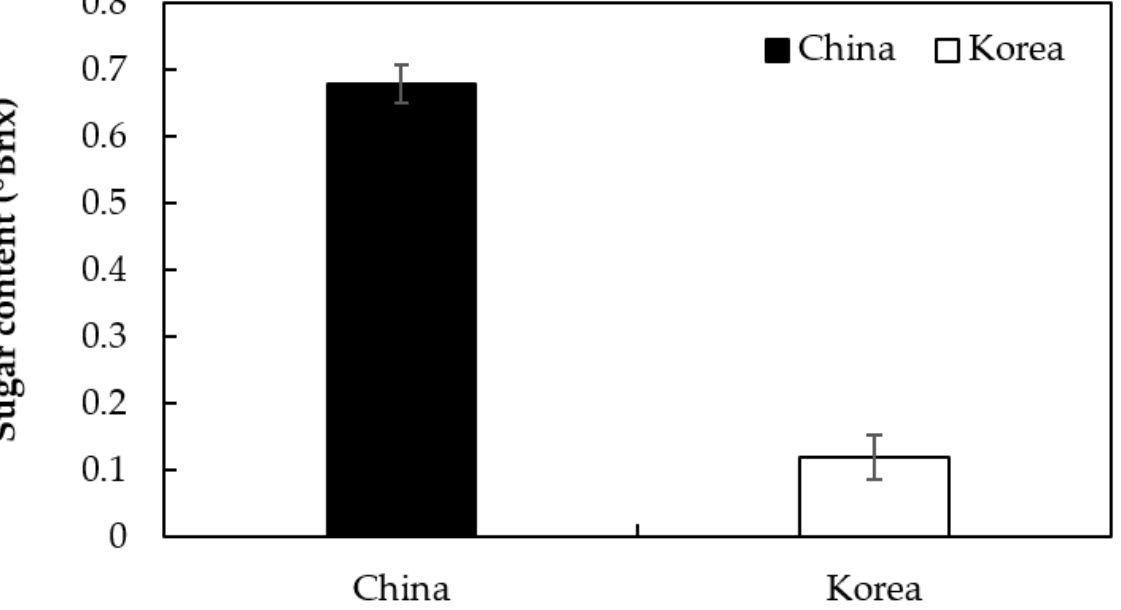
Figure 5. Sugar content of the water tube solution used for cut Phalaenopsis “V3” flowers in Fall based on the place of origin.